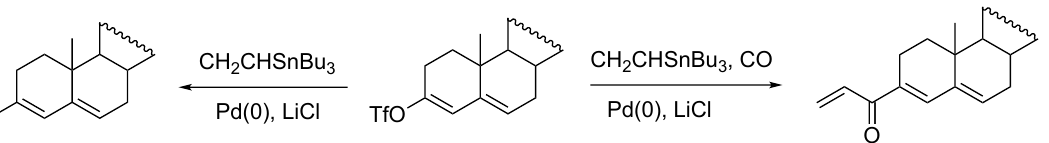
Figure 12. Pd-catalyzed vinylation and carbonylative vinylation of steroidal triflates. Steroidal phenyl ketones were prepared in high yields by palladium-catalyzed car- bonylation reactions of 17-iodo-androst-16-ene derivatives under mild reaction conditions, with NaBPh 4 as phenylating agent. Alkenyl bromides or enol triflates resulted in lower yields as compared to the alkenyl iodides (Figure 13) [67].